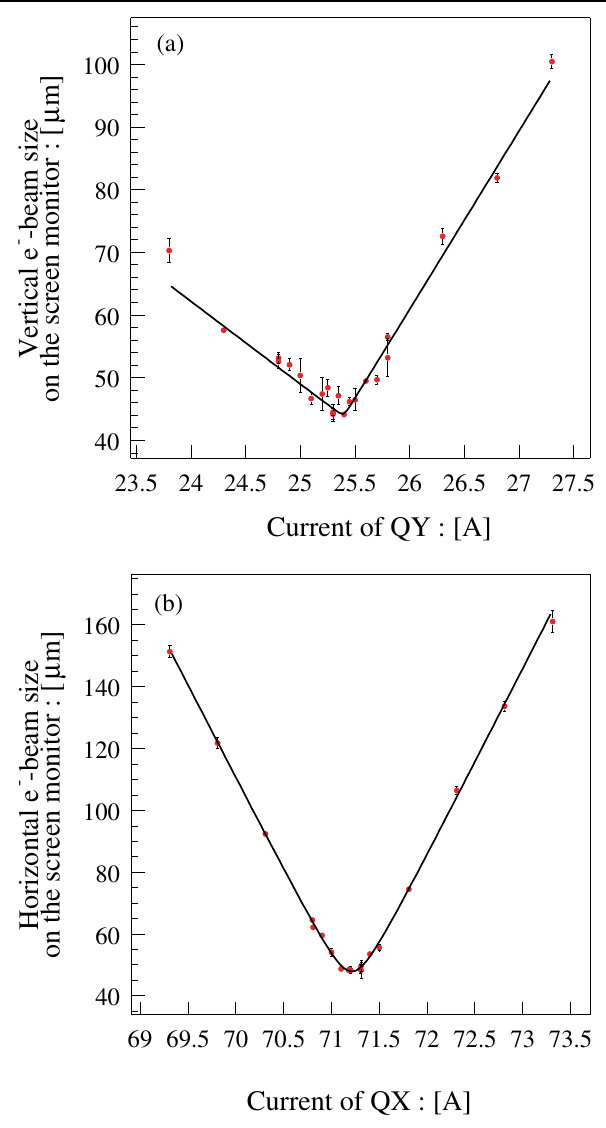
FIG. 9. (Color) Experimental results of the error corrections: Changing the current of the Q magnets, the beam size on the screen monitors are measured at the collision point: (a) for the y direction as a function of the current of QY ; (b) for the x direction as a function of the current of QX